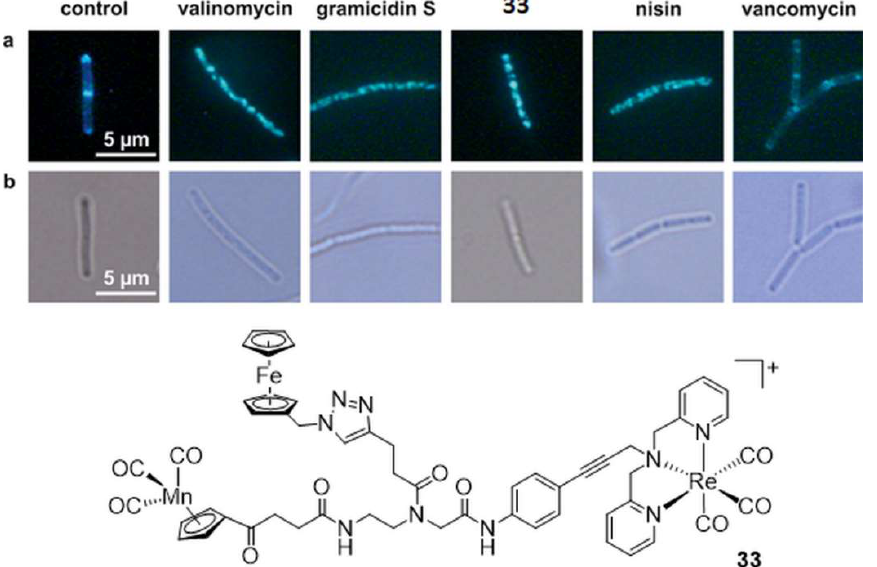
Figure 7. Top: influence of hetero-tri-organometallic compound 33 of Metzler-Nolte and Bandow on the B. subtilis membrane and cell wall integrity. ( a ) GFP-MinD (green fluorescent cell division protein) localization after treatment with molecule 33 and approved antibiotics (valinomycin, gramicidin S, nisin, and vancomycin). Like valinomycin, gramicidin S, or nisin (positive control), 33 leads to GFP-MinD delocalization, demonstrating membrane depolarization by the molecule. Note that vancomycin here represents the negative control. ( b ) Light microscopy images corresponding to panel a. Bottom: structure of the hetero-tri-organometallic molecule 33 . Figure readapted with permission from publisher [80] .